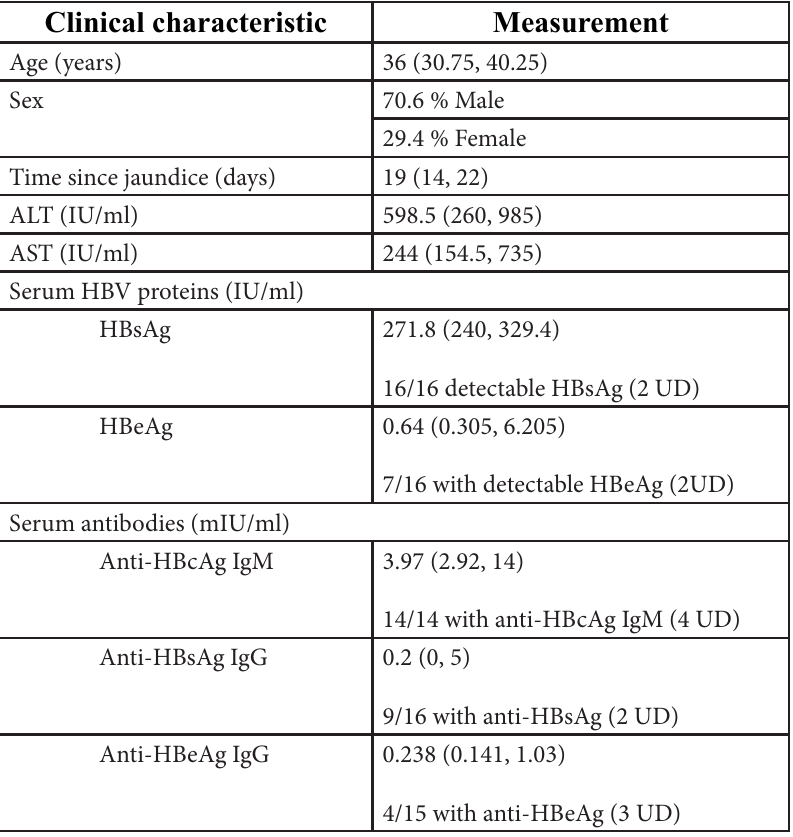
Table 1. Clinical data for HBV+ individuals Clinical